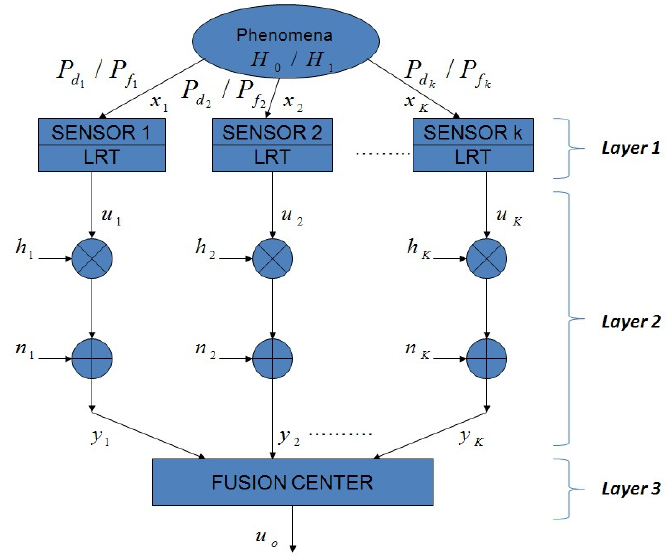
Figure 2. Proposed three-layer parallel WSN system model where the LRT is applied at the sensors